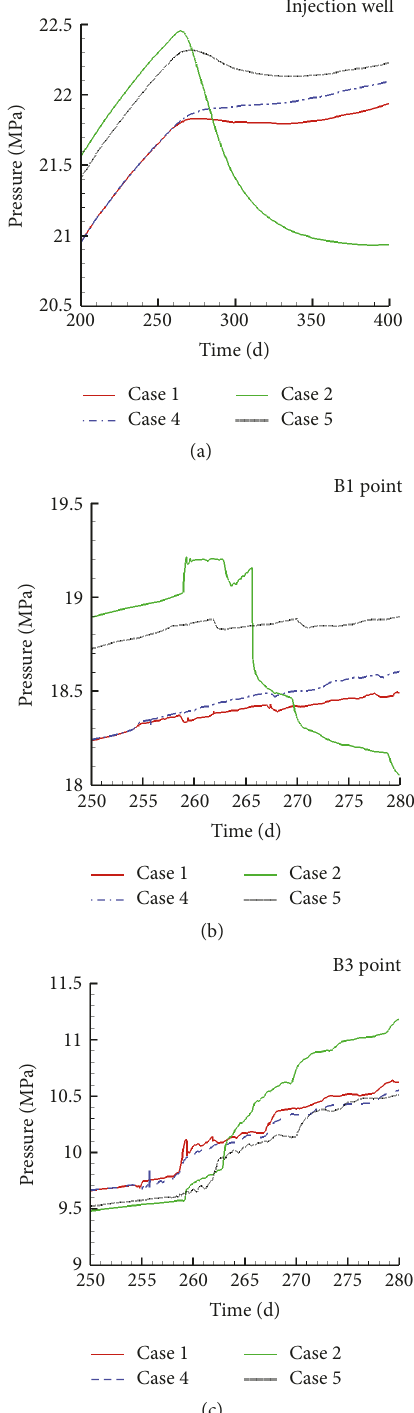
Figure 18: Models comparison (Case 1 versus Case 4, Case 2 versus Case 5) in terms of pressure response at injection well and the bottom and top of